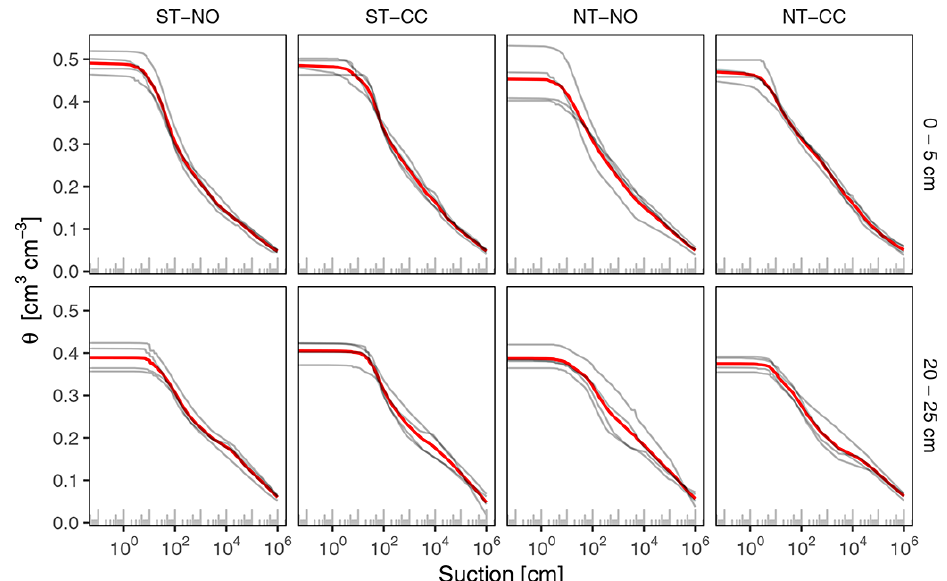
Figure A2. Water retention curves of top and subsurface layers by treatment. Gray curves are individual soil core measurements, and thick red curves are the treatment means.